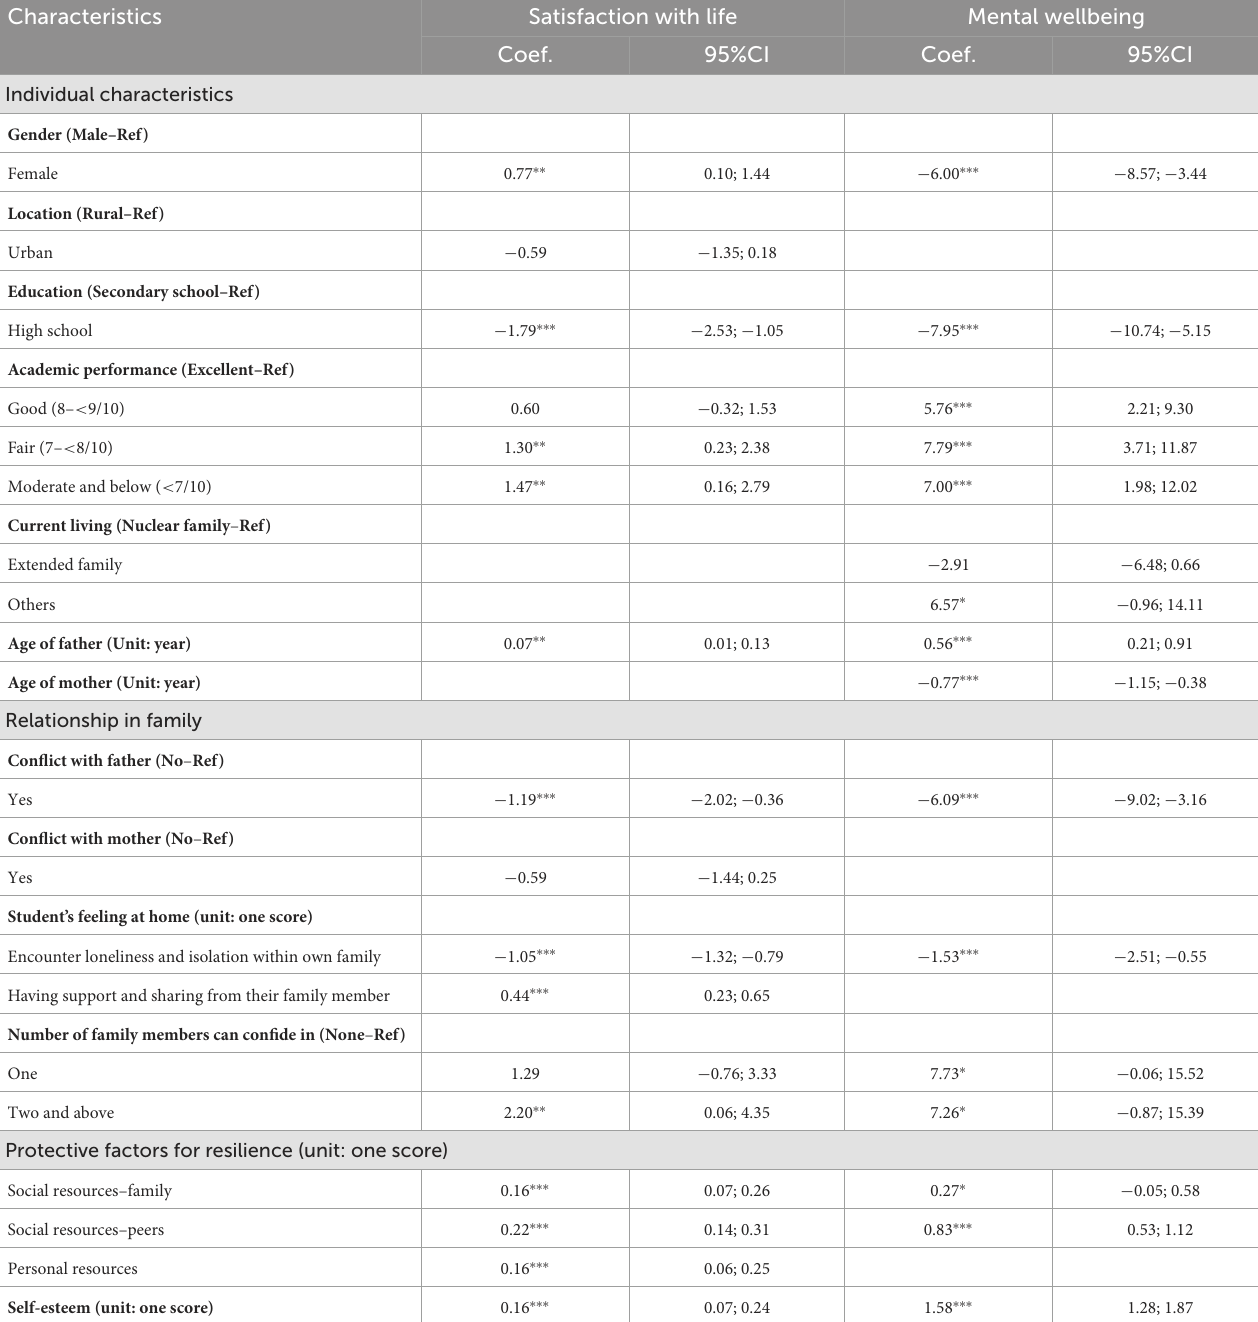
TABLE 4 Tobit regression for identifying factors related to satisfaction with life and mental wellbeing among students. Characteristics Satisfaction with life Mental wellbeing Coef. 95%CI Coef.